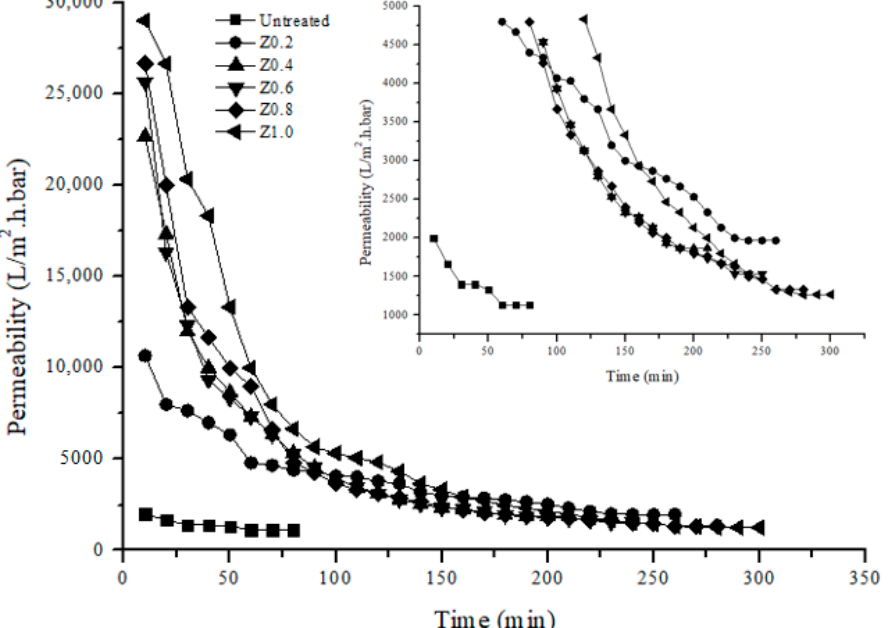
Figure 8. Pure water permeability for untreated nylon 6,6 NFM and nylon 6,6 / ZIF-8 NFM with condition pressure at 0.1 bar. The inset shows water permeability value near steady-state.